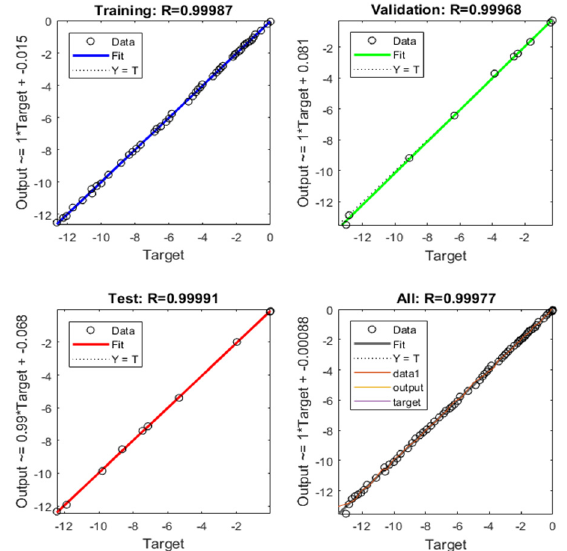
Figure 11. The correlation value of laboratory data and the ANN method (BRC-2 beam).